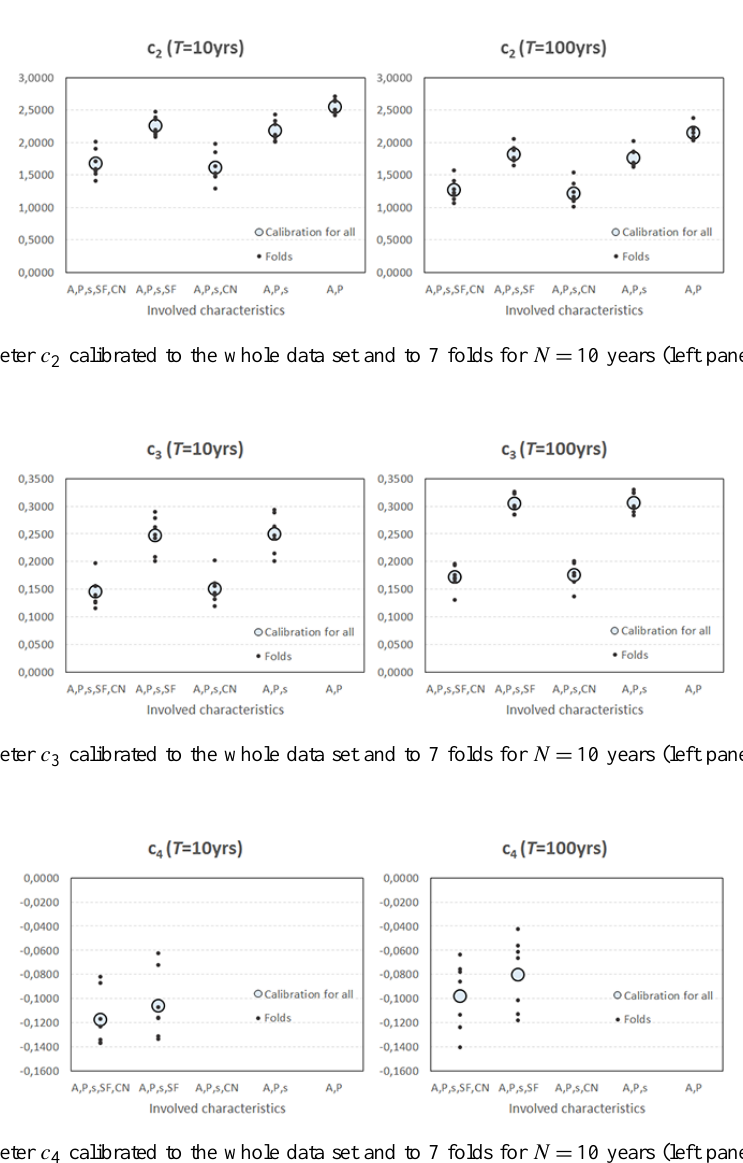
Figure 21. Values of parameter c 1 calibrated to the whole data set and to 7 folds for N = 10 years (left panel) and N = 100 years (right panel).